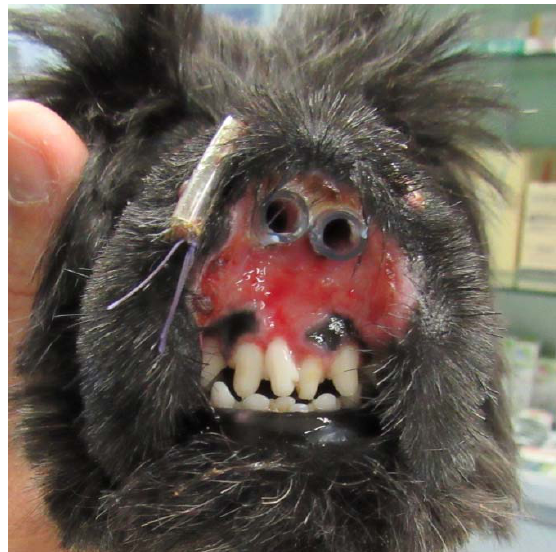
Figure 2. Frontal view of the muzzle after the application of endonasal stents.